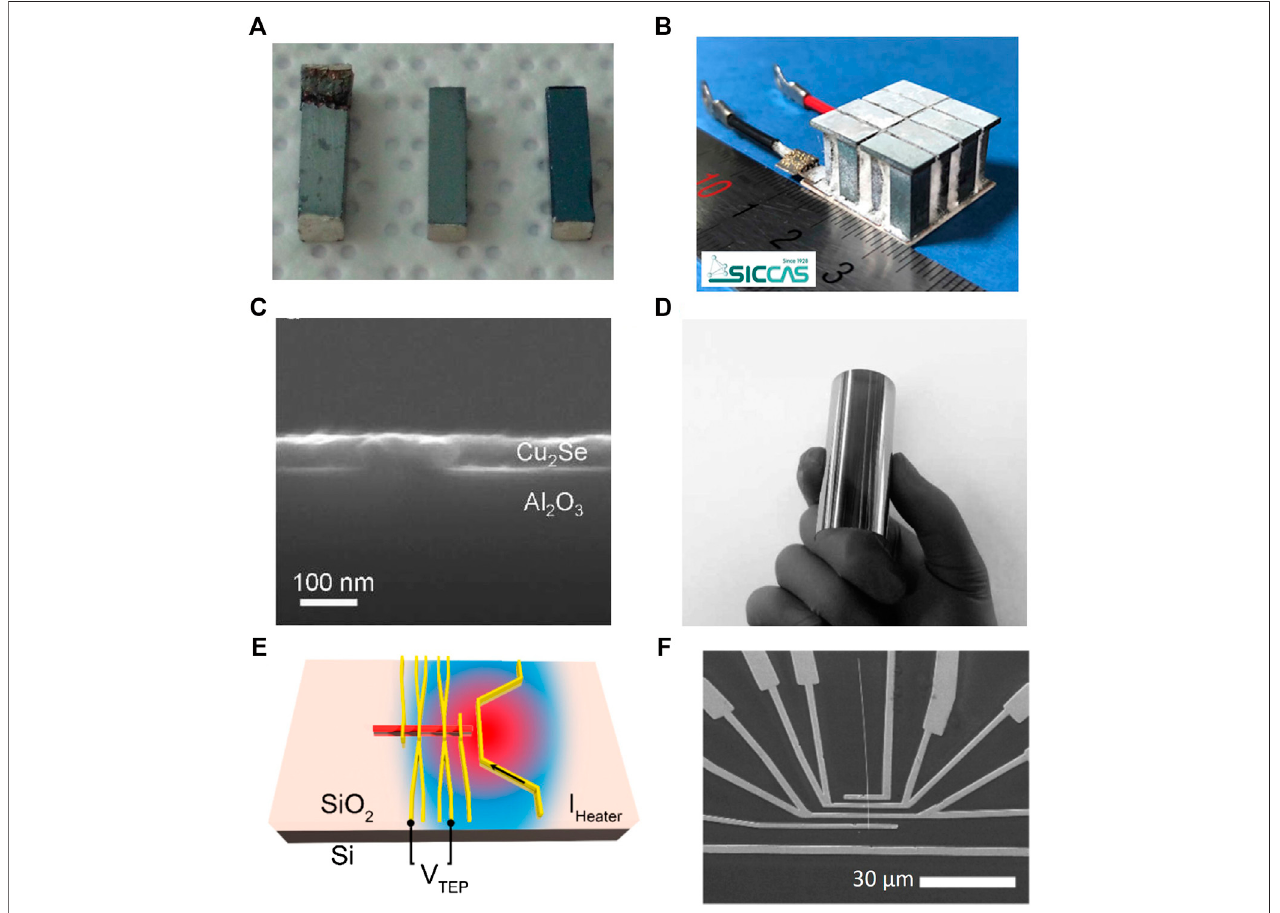
Figure 2 | (A) Cu 2 S leg at a current density of 24 A cm − 2 for 24 h and Cu 1.8 S and CuS legs both after a stress of 48 A cm − 2 for 72 h (from the left to right). Reproduced with permission (Dennler et al., 2014) Copyright 2014, Wiley-VCH. (B) Optical image of the eight-couple Cu 2 Se/Yb 0.3 Co 4 Sb 12 TE module. Reproduced with permission (Qiu et al., 2019) Copyright 2019, Elsevier Inc. (C) Cross-sectional scanning electron microscope (SEM) image of the Cu 2 Se fi lm on Al 2 O 3 substrate. (D)